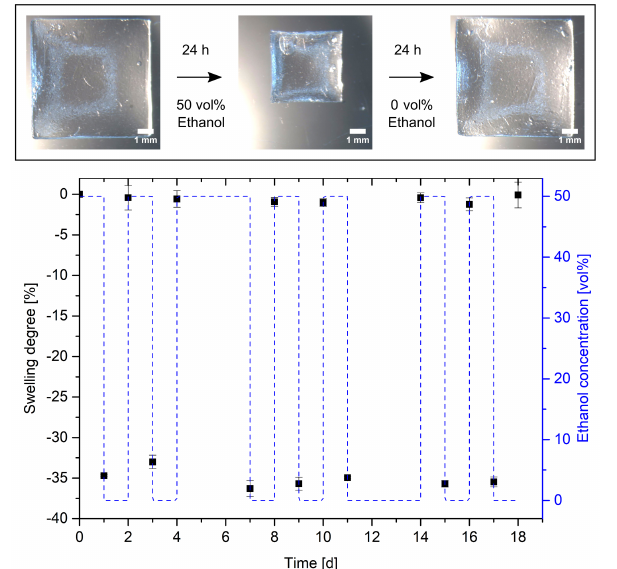
Figure 4. Reversible hydrogel swelling versus ethanol concentra- tion (hydrogel: 10vol%Aam and